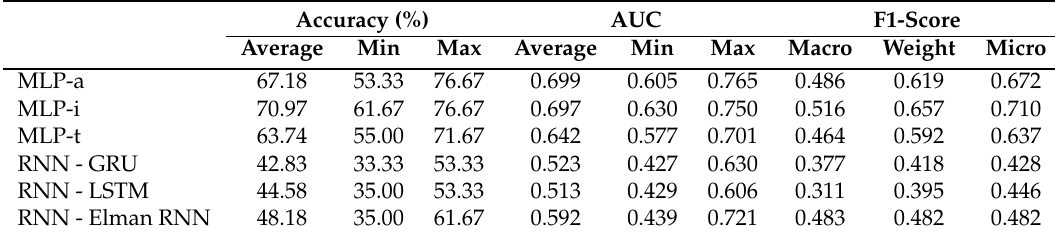
Table 11. Final test results—1000 iterations of five-fold cross-validation.